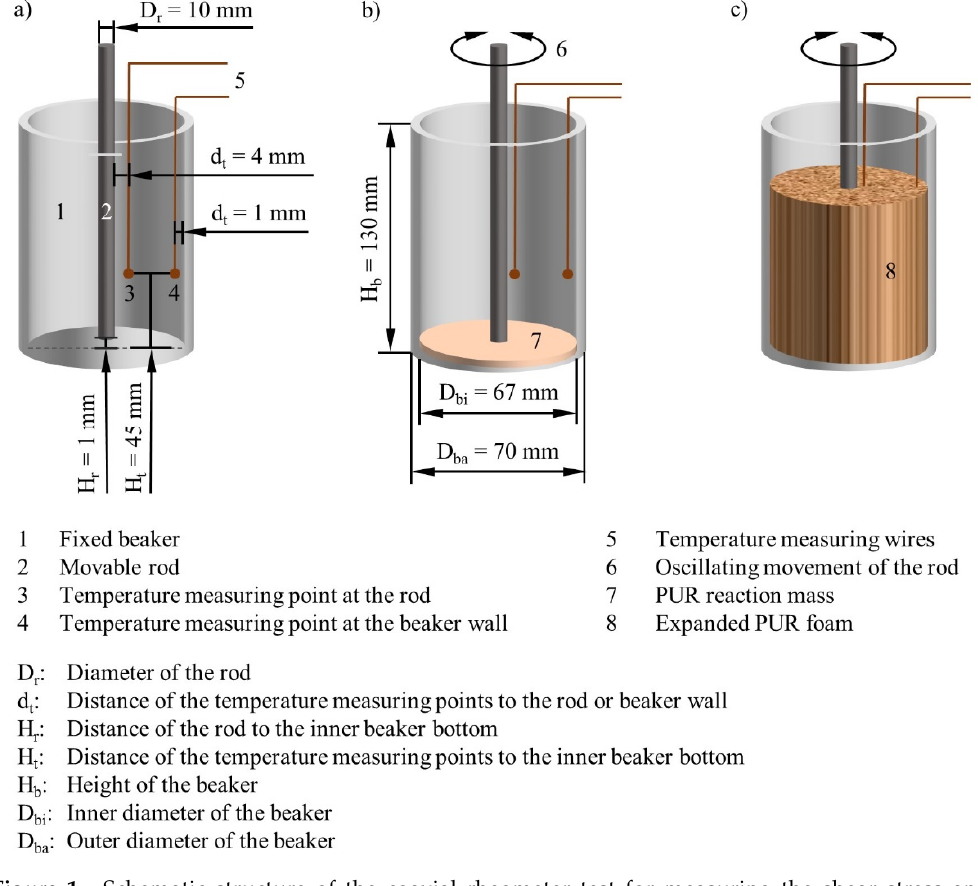
Figure 1. Schematic structure of the coaxial rheometer test for measuring the shear stress and temperature within expanding and curing polyurethane foam ( a ) before and ( b ) after filling in the PUR reaction mass as well as ( c ) after expansion.